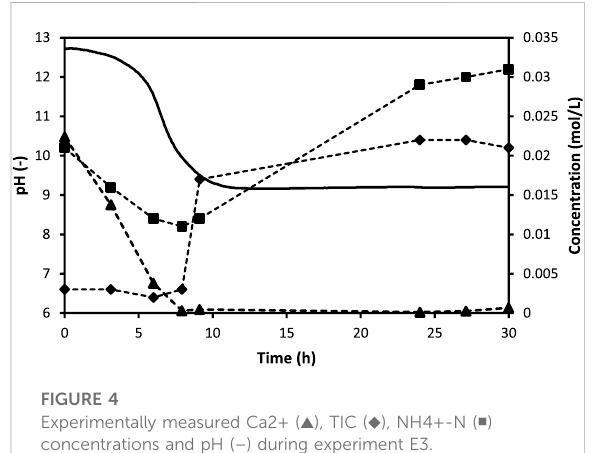
FIGURE 4 Experimentally measured Ca2+ ( ▲ ), TIC ( ◆ ), NH4+-N ( ■ ) concentrations and pH ( – ) during experiment E3.